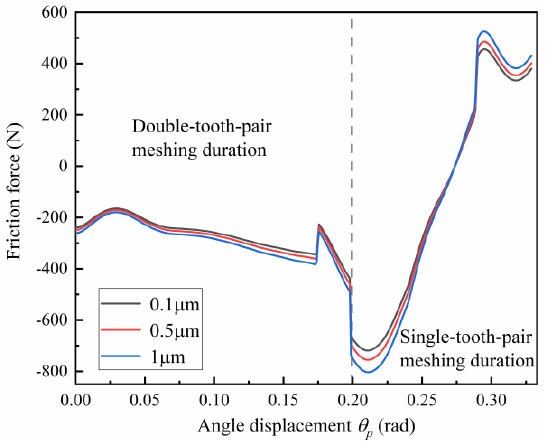
Figure 9. Friction coefficient under different wear severities.